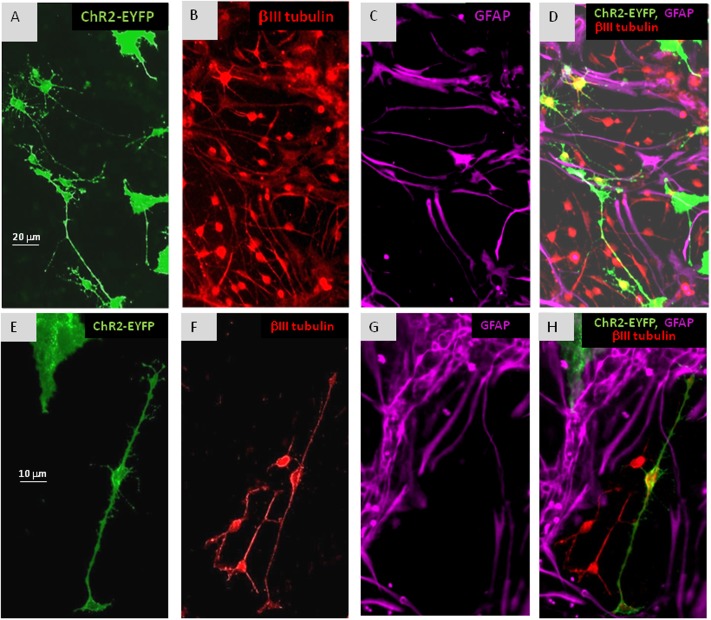
In cultures of mixed ChR2+ and ChR2- cells, withdrawal of EGF resulted in the appearance of βIII-tubulin immunopositive (B,D,F,H: red) neuronal precursors among both, ChR2+ (eYFP fluorescent; A,D,E,H: green) and ChR2- cells in 5 days. ChR2+ was expressed by GFAP-immunoreactive (C,D,G,H: purple) and GFAP negative substrate attached cells, as well. The process-bearing shape of βIII-tubulin immunopositive neuronal precursors is demonstrated in higher magnification on (E–H).